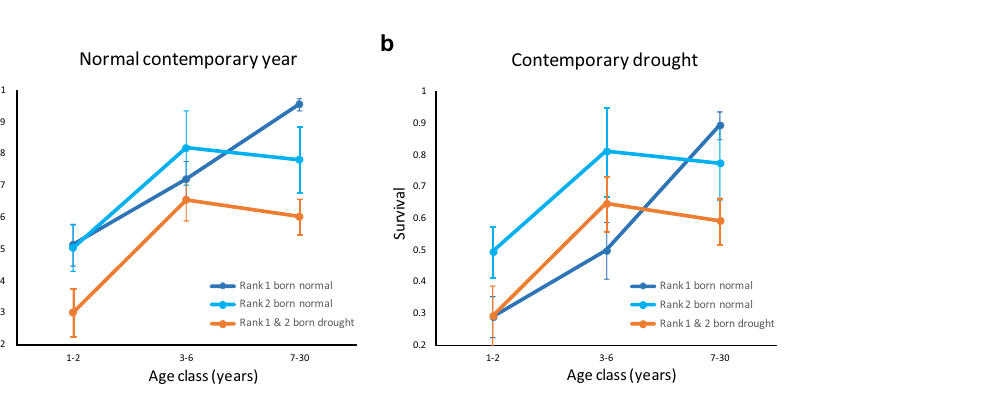
expected for its age, see Methods; N =273 and 94). Symbols: in each boxplot, the centrelinerepresentsthemedian,the “ X ” symbolthemeanvalue,thelengthofthe box extendsthroughthe interquartile range(IQR) andthe whiskersextend to 1.5× IQR. All data points outside this range are plotted individually. Source data are provided as a Source Data fi le.